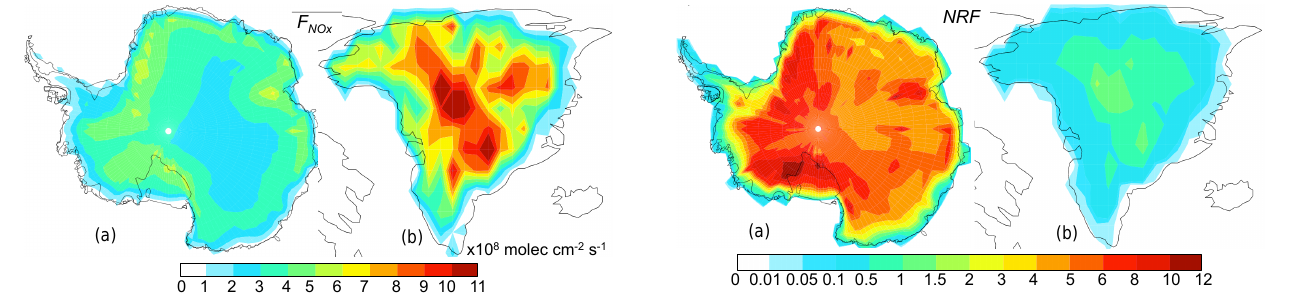
Figure 5. Mean summer (DJF, Antarctica; JJA, Greenland) flux of snow-sourced NO x from the snow ( F NO